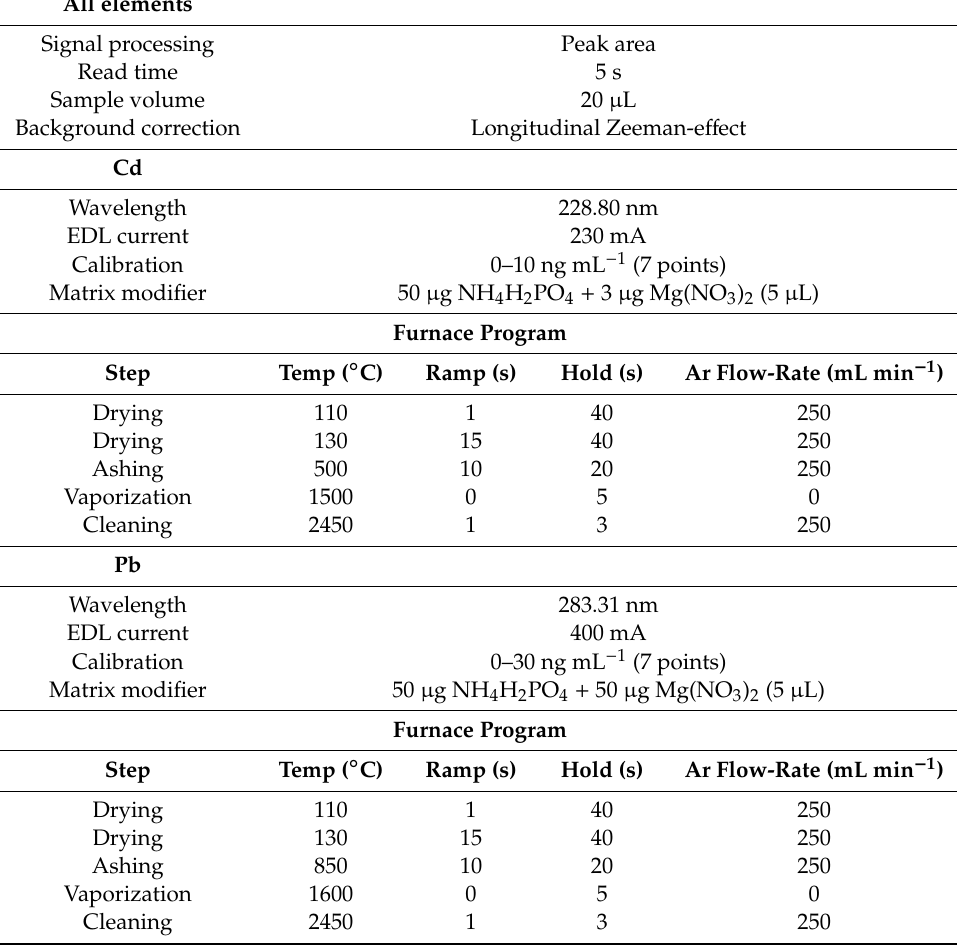
Table 1. Operation conditions for Cd and Pb determination in zeolites by graphite furnace atomic absorption spectrometry